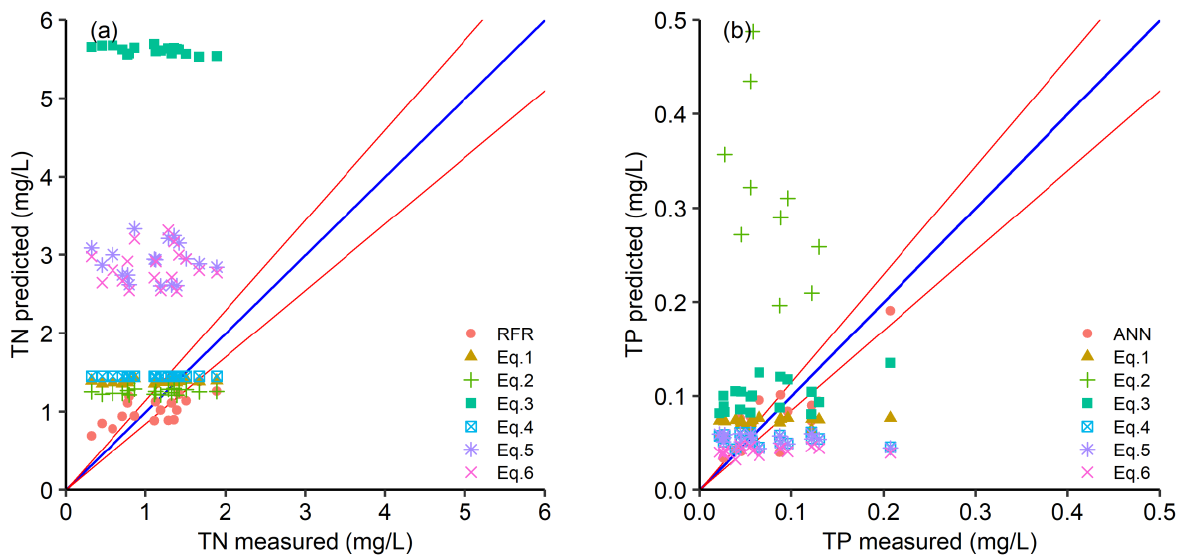
Figure 7. Comparison of prediction performance between machine learning algorithms and previous regression equations for TN ( a ) and TP ( b ) in the NRD.